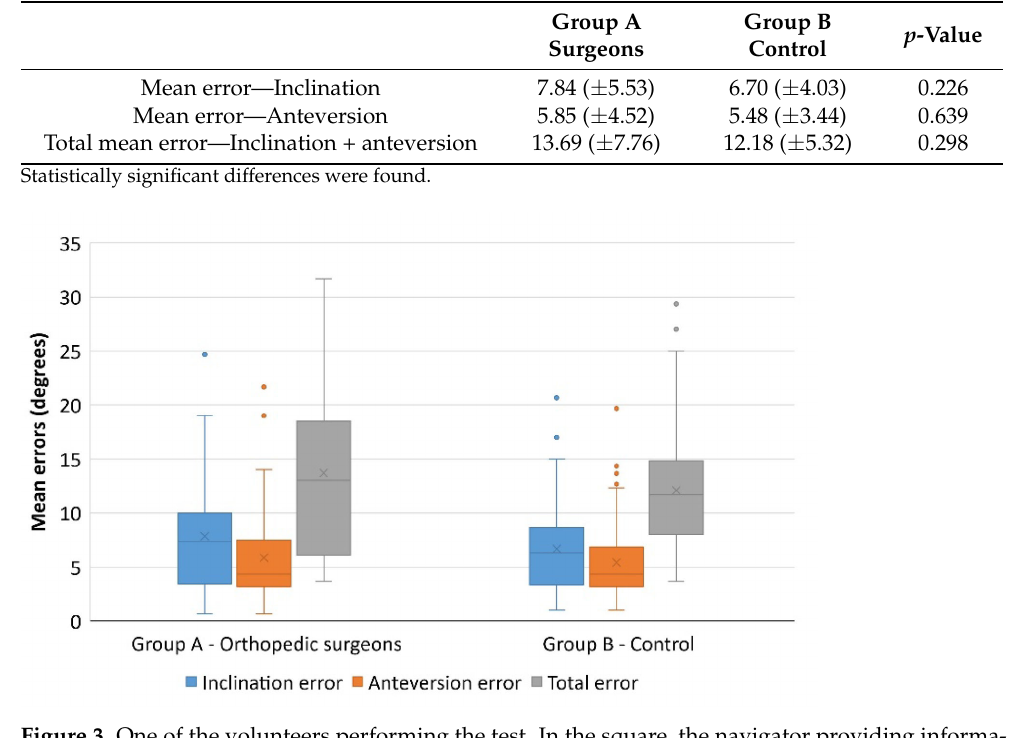
Figure 3. One of the volunteers performing the test. In the square, the navigator providing informa- tion on inclination and